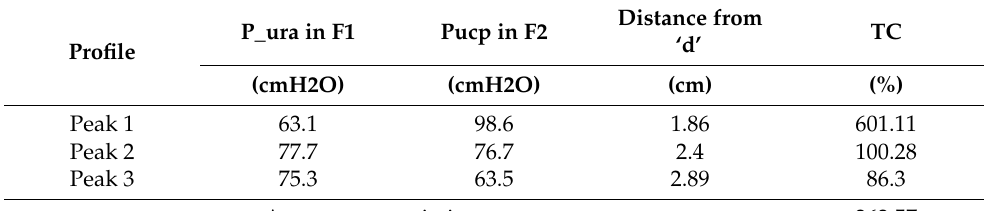
Table 2. Stress profilometry measurements